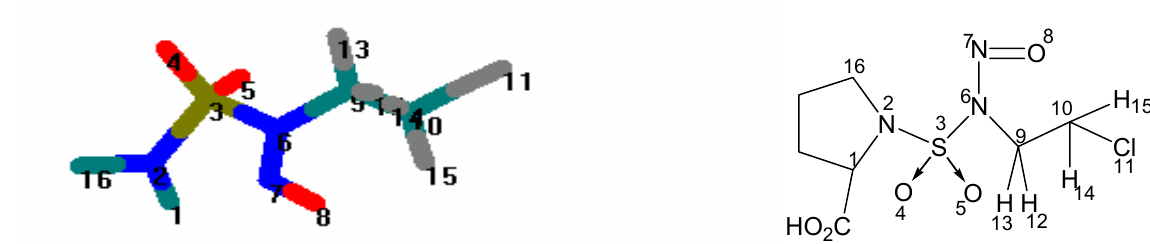
Figure 4: Common fragment of the four CENS. Figure 5: N-nitroso-N-(2-chloroethyl)-N’- sulfamoylproline